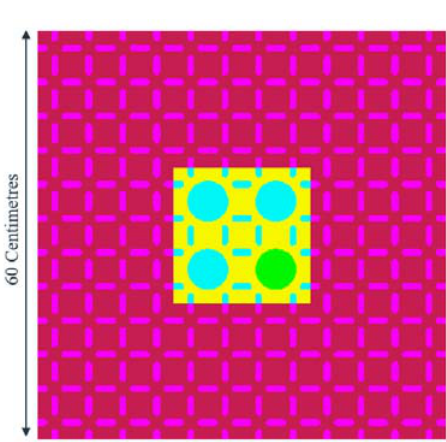
Figure 5: WIMS super cell geometric structure (no control rods inserted)